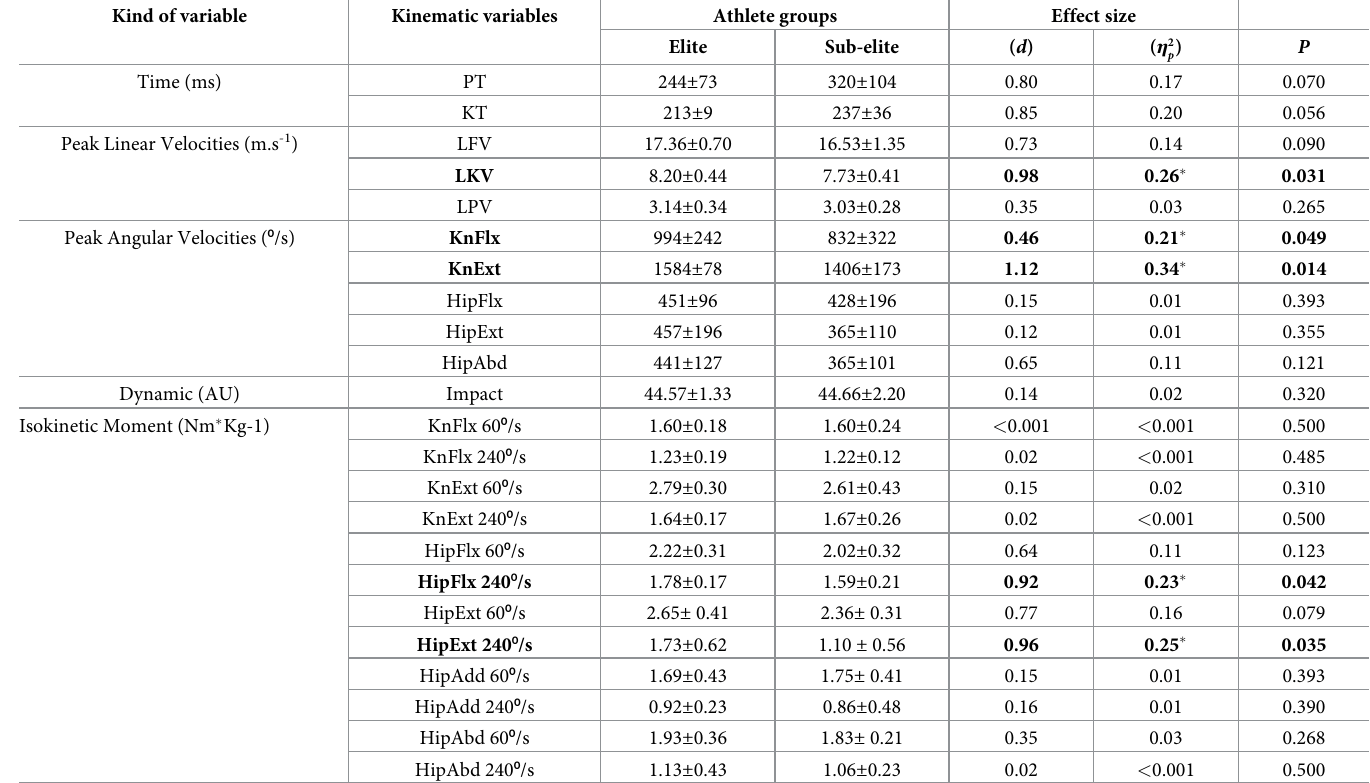
Table 1. Comparative data for kinematic and dynamic variables obtained during bandal chagi and isokinetic evaluations for each group of athletes. Kind of